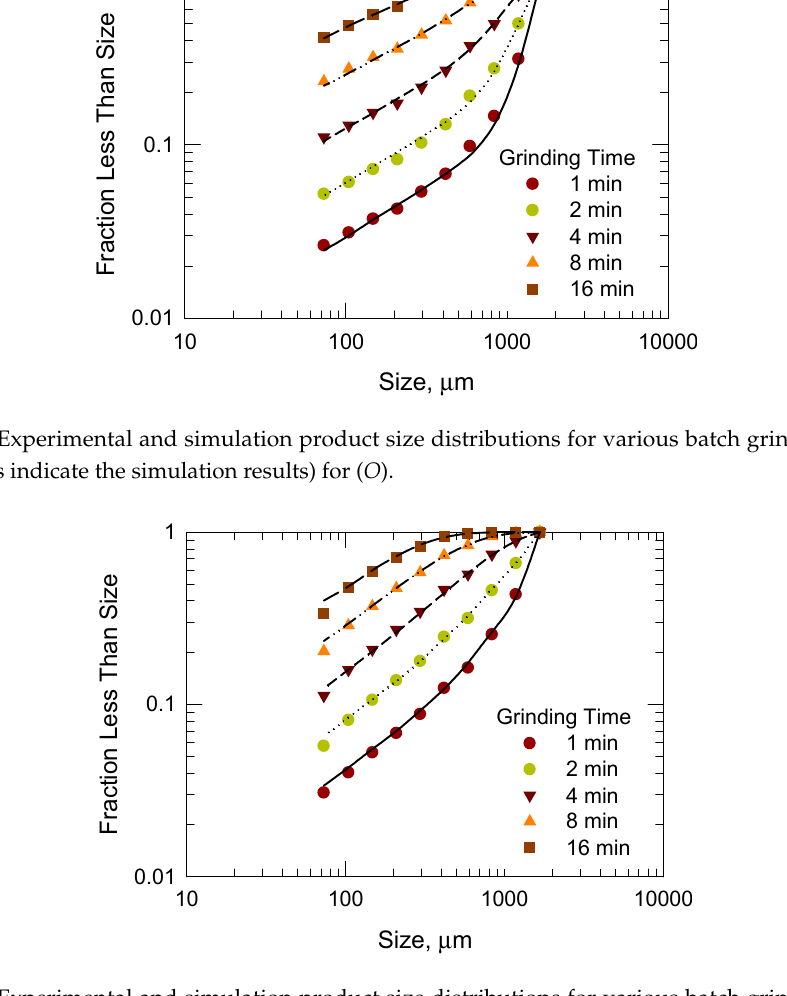
Figure 7. Experimental and simulation product size distributions for various batch grinding times (solid lines indicate the simulation results) for ( B ) .